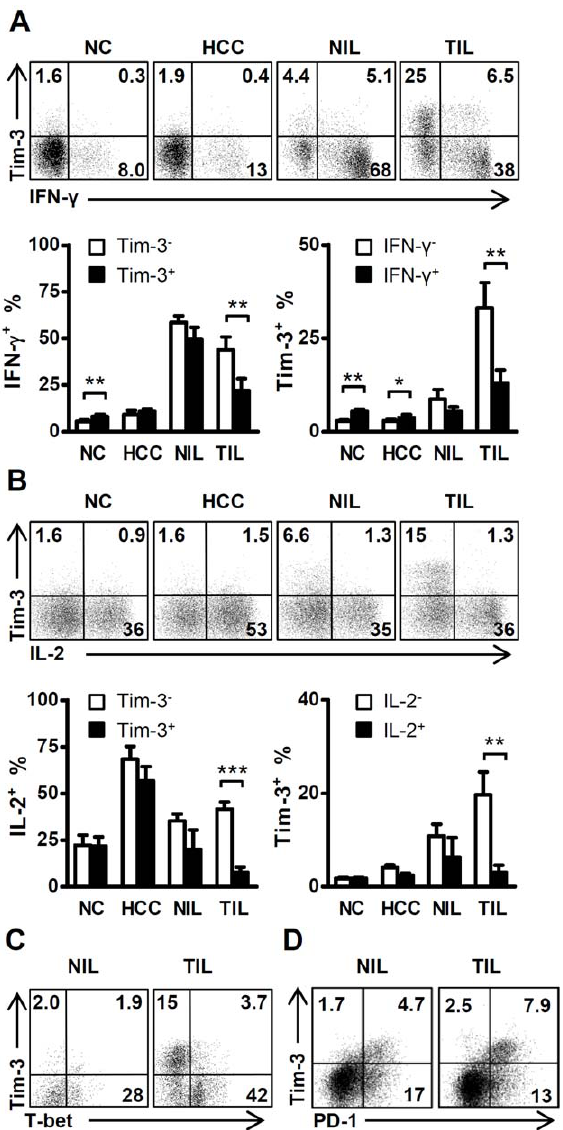
Figure 2. Tumor-infiltrating Tim-3 + CD4 T cells exhibit impaired ability to produce Th1-type cytokines. A . Representative FACS analysis illustrating the association between IFN- c and Tim-3 expression in CD4 T cells isolated from the PBMCs of normal healthy controls (NC, n =15) and HCC patients (HCC, n =10), and nontumor-infiltrating lymphocytes (NILs, n =6) and tumor-infiltrating lymphocytes (TILs, n =6) from HCC patients. Statistical analysis showed the mean percentage of IFN- c + cells in the Tim-3 positive or negative CD4 T cell subsets (left), and the proportion of Tim-3 + cells in the IFN- c positive or negative CD4 T cell subsets (right). B . Relationship between